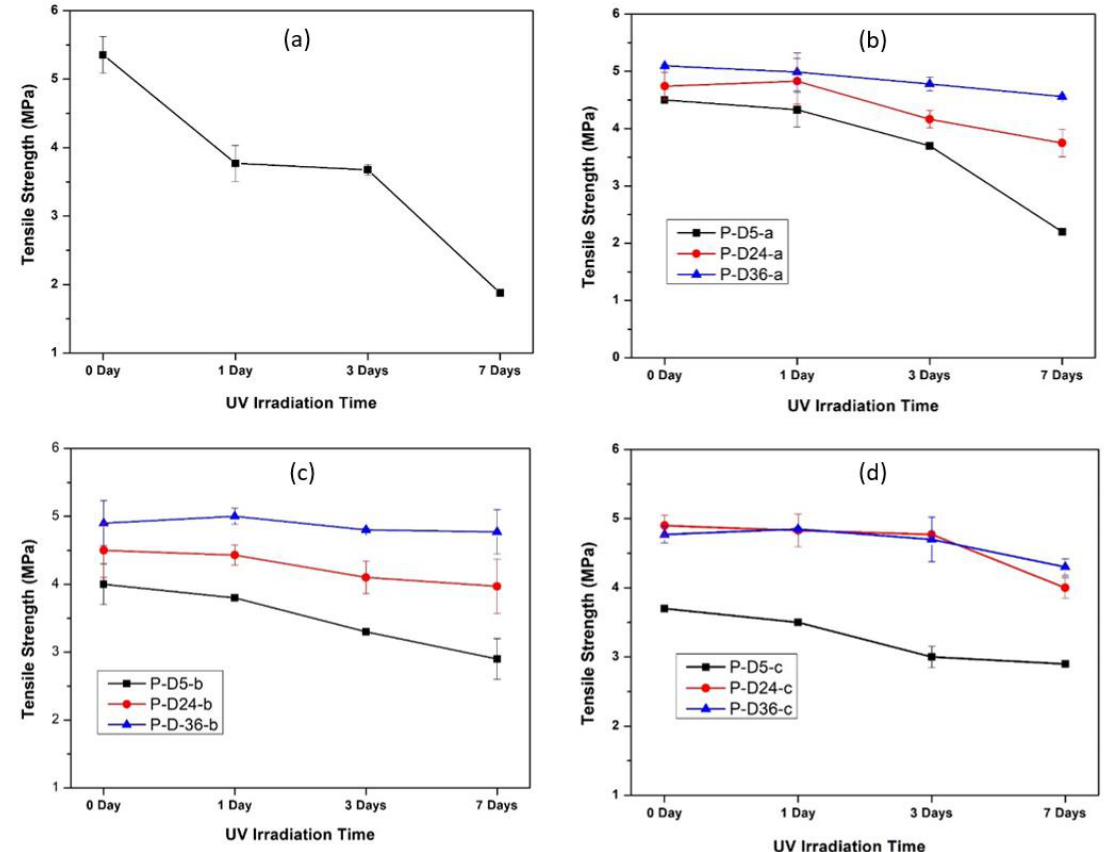
Figure 9. Tensile strength of original and modified membranes before and after UV exposure: ( a ) pristine PSF, ( b ) 0.5% dopamine loading at different polymerization times, ( c ) 2.0% dopamine loading at different polymerization times, and ( d ) 4.0% dopamine loading at different polymerization times. The data are presented as average±standard deviation from n = 5.